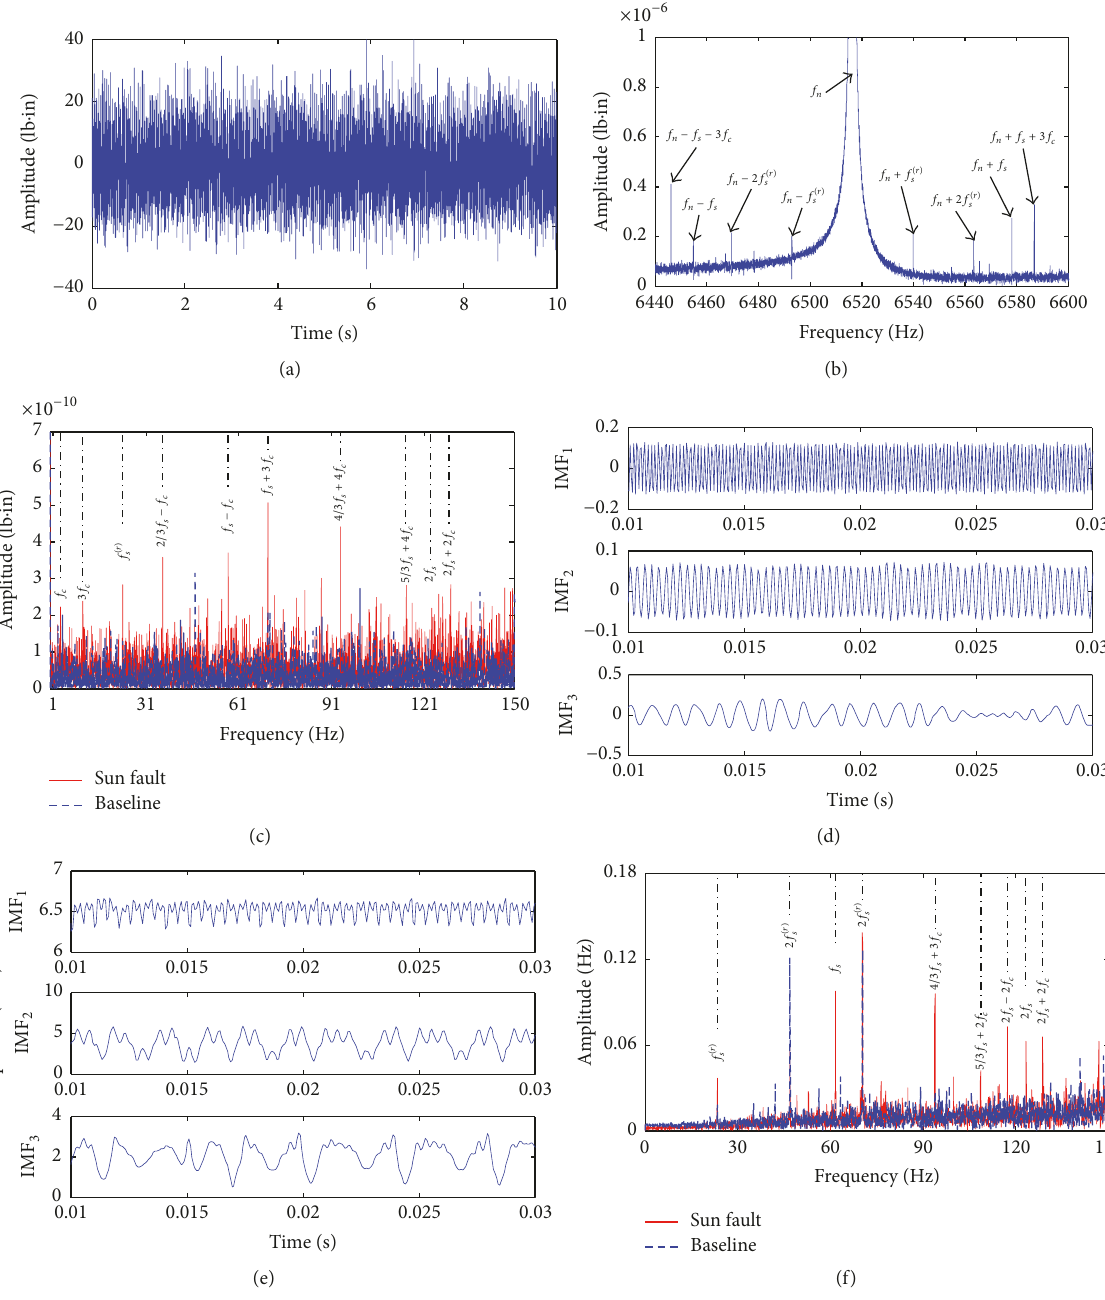
Figure 11: Sun gear fault signal analysis: (a) detrended torsional vibration signal, (b) Fourier spectrum, (c) envelop spectrum, (d) IMFs, (e) instantaneous frequencies of IMFs, and (f) Fourier spectrum of instantaneous